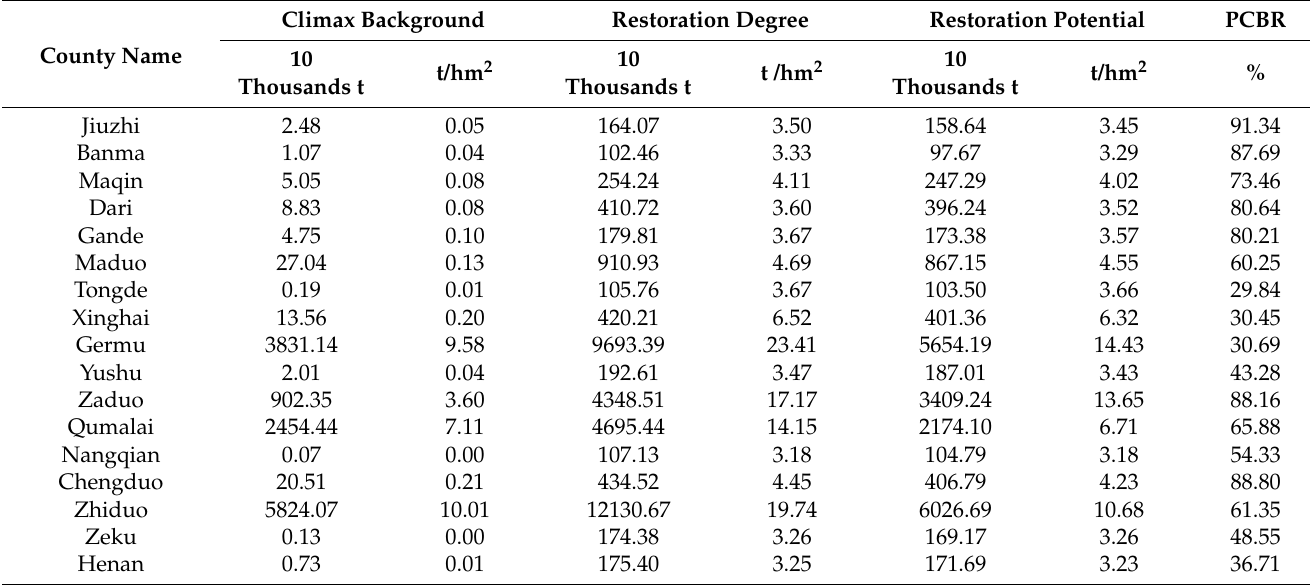
Table 5. Statistical table of climax background, restoration degree, restoration potential, and PCBR of WD in TRHR’s